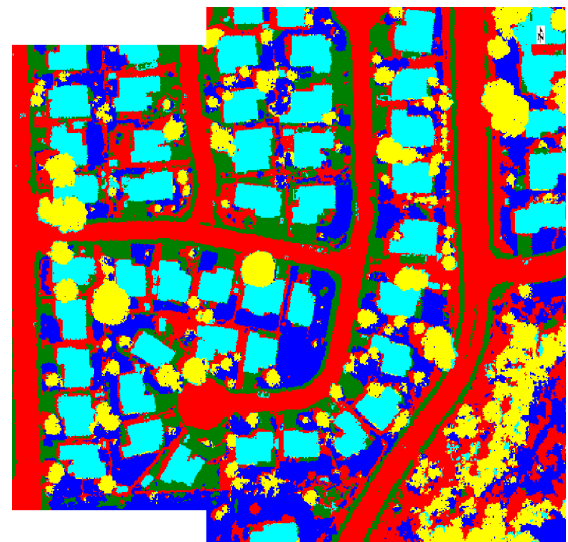
Figure 8. Merge of two classification images. The Softmax Regression classifier was trained on the attribute image corresponding to the right classification image and then applied on the attribute image corresponding to the left classification